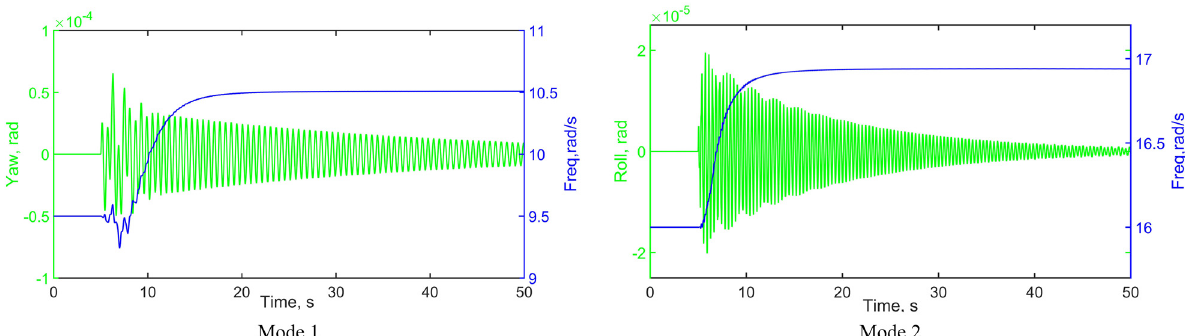
Figure 14: Identi fi cation of natural frequencies.